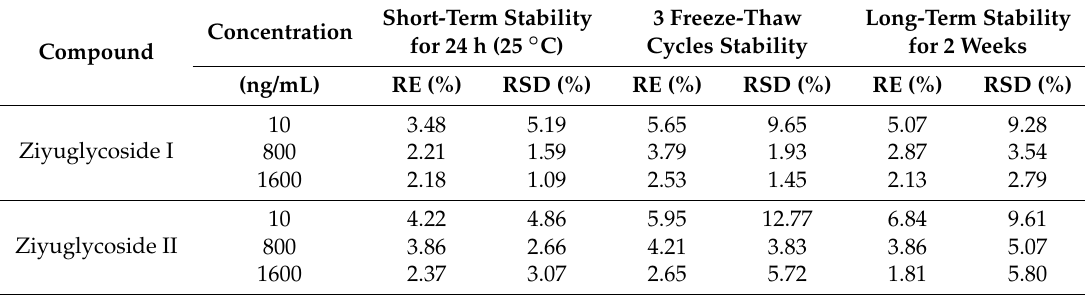
Table 6. Stability data of ZGS1 and ZGS2 in rat plasma ( n = 5). Short-Term Stability Concentration for 24 h (25 ◦ C) Cycles Compound